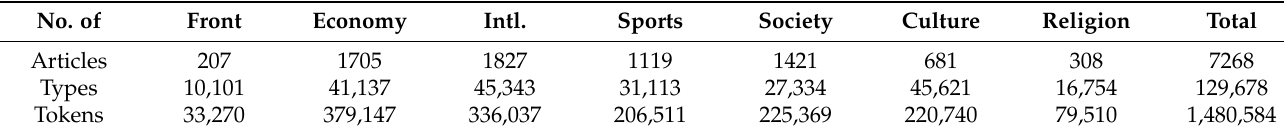
Table 1. Basic statistical information about the 2021 Saudi newspapers.